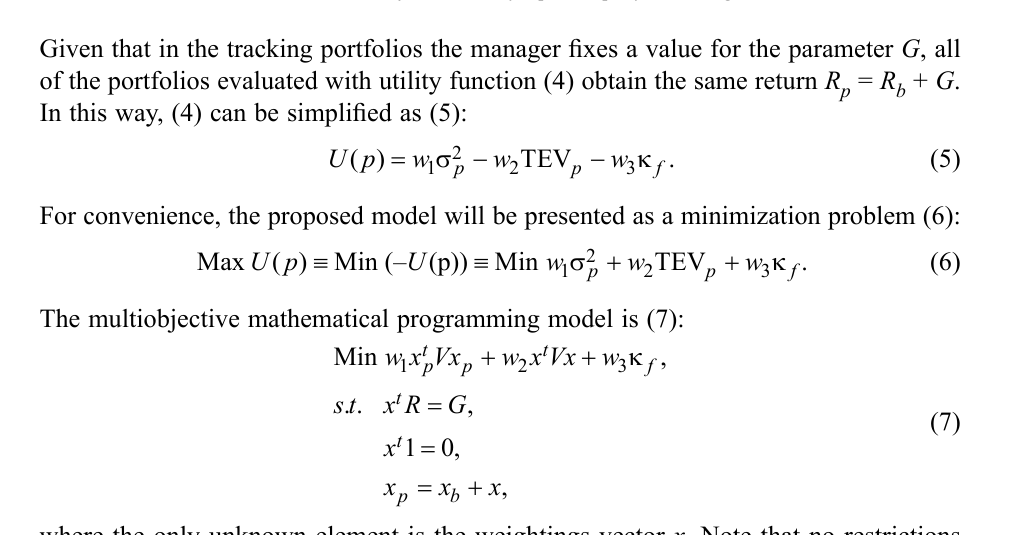
Algorithm 1. Adaptation of the algorithm by Tabata and Takeda (1995)